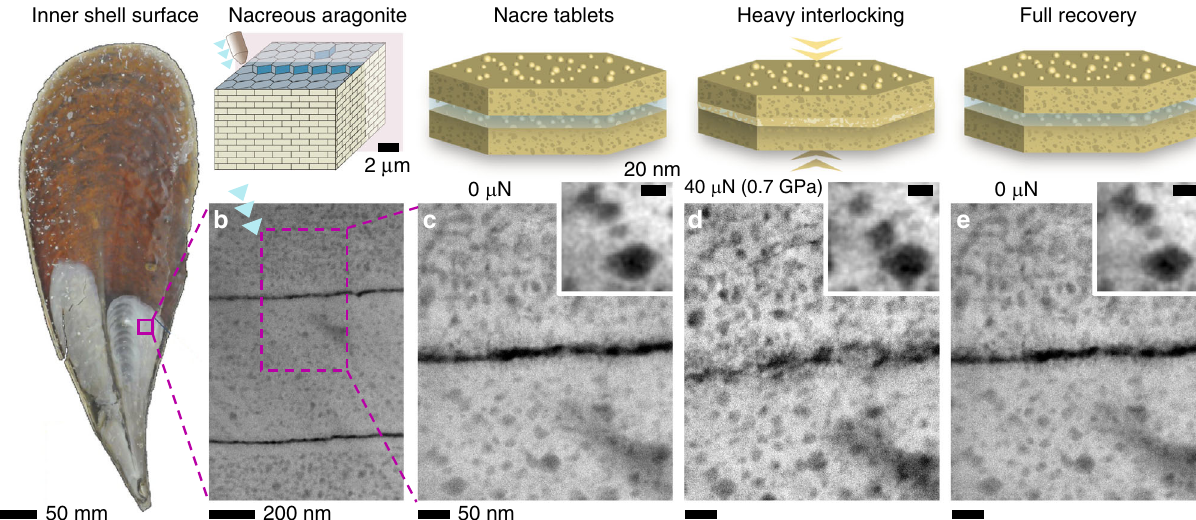
Fig. 1 Highly deformed and recovered nacre. a Schematic of the inner shell surface of the bivalve mollusk P. nobilis , with the investigated area marked by a purple square. b HAADF STEM overview image of cross-sectional interface of nacre tablets before compression. c High-resolution STEM image of two tablets and their organic interface before compression. d Tablets heavily interlocked under 40 µ N compressive load. e After indenter is retracted, tablets and organic interface have fully recovered their initial morphology. Insets show the movement of organic inclusions due to the deformation of the tablet and their complete recovery after removing the compressive load